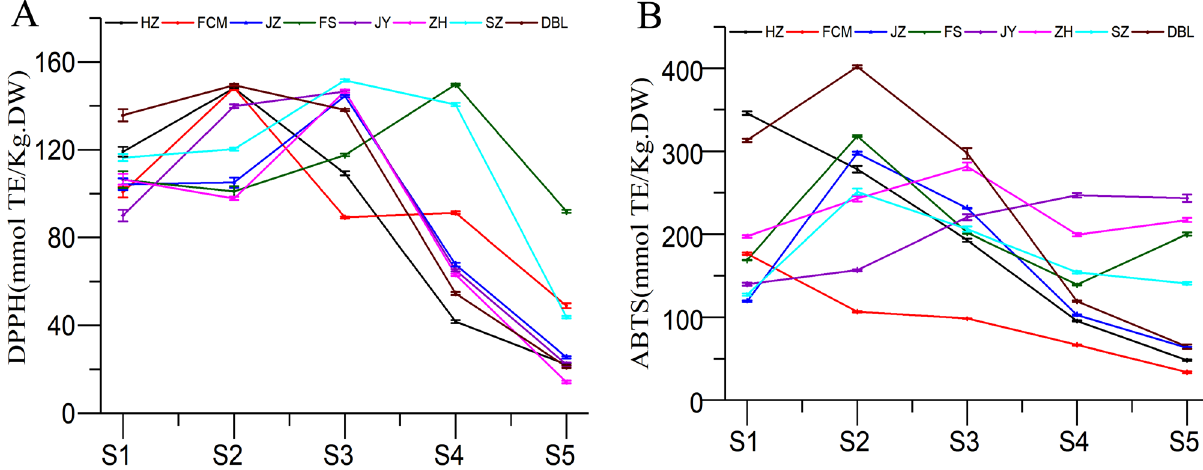
Figure 10. Antioxidant activity shown by ( A ) DPPH and ( B ) ABTS methods in extracts of jujube